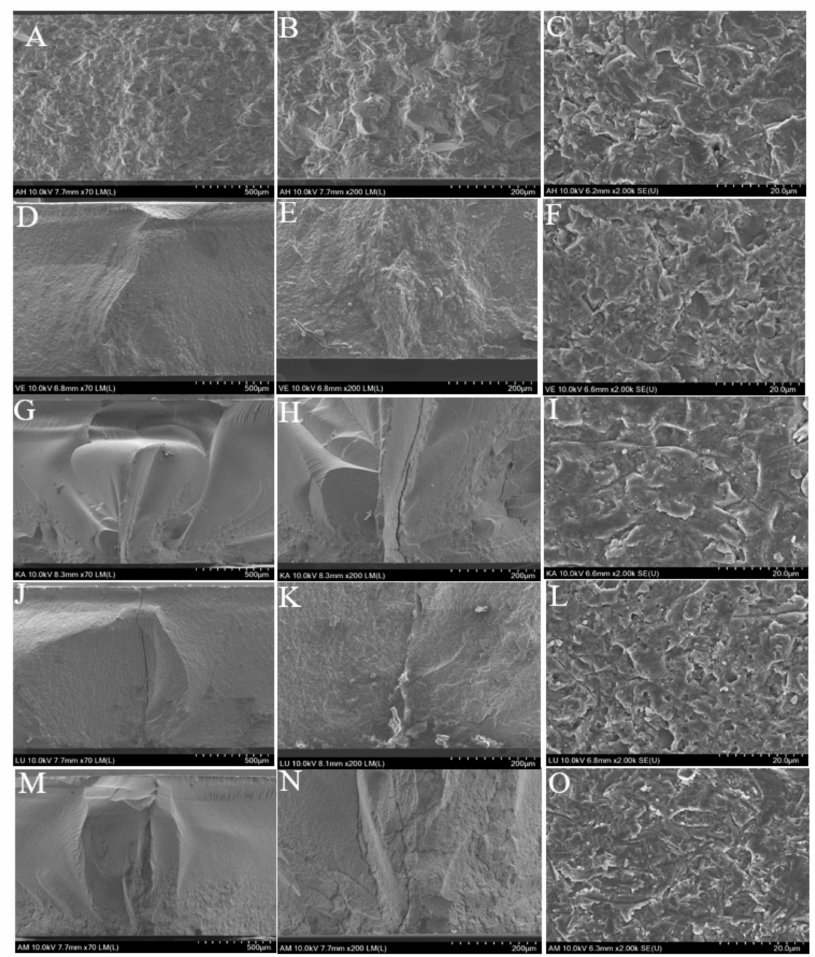
Figure 11. SEM images of fractured surface after biaxial flexural strength test; ( A – C ): AH; ( D – F ): VE; ( G – I ): KA; ( J – L ): LU; ( M – O ):